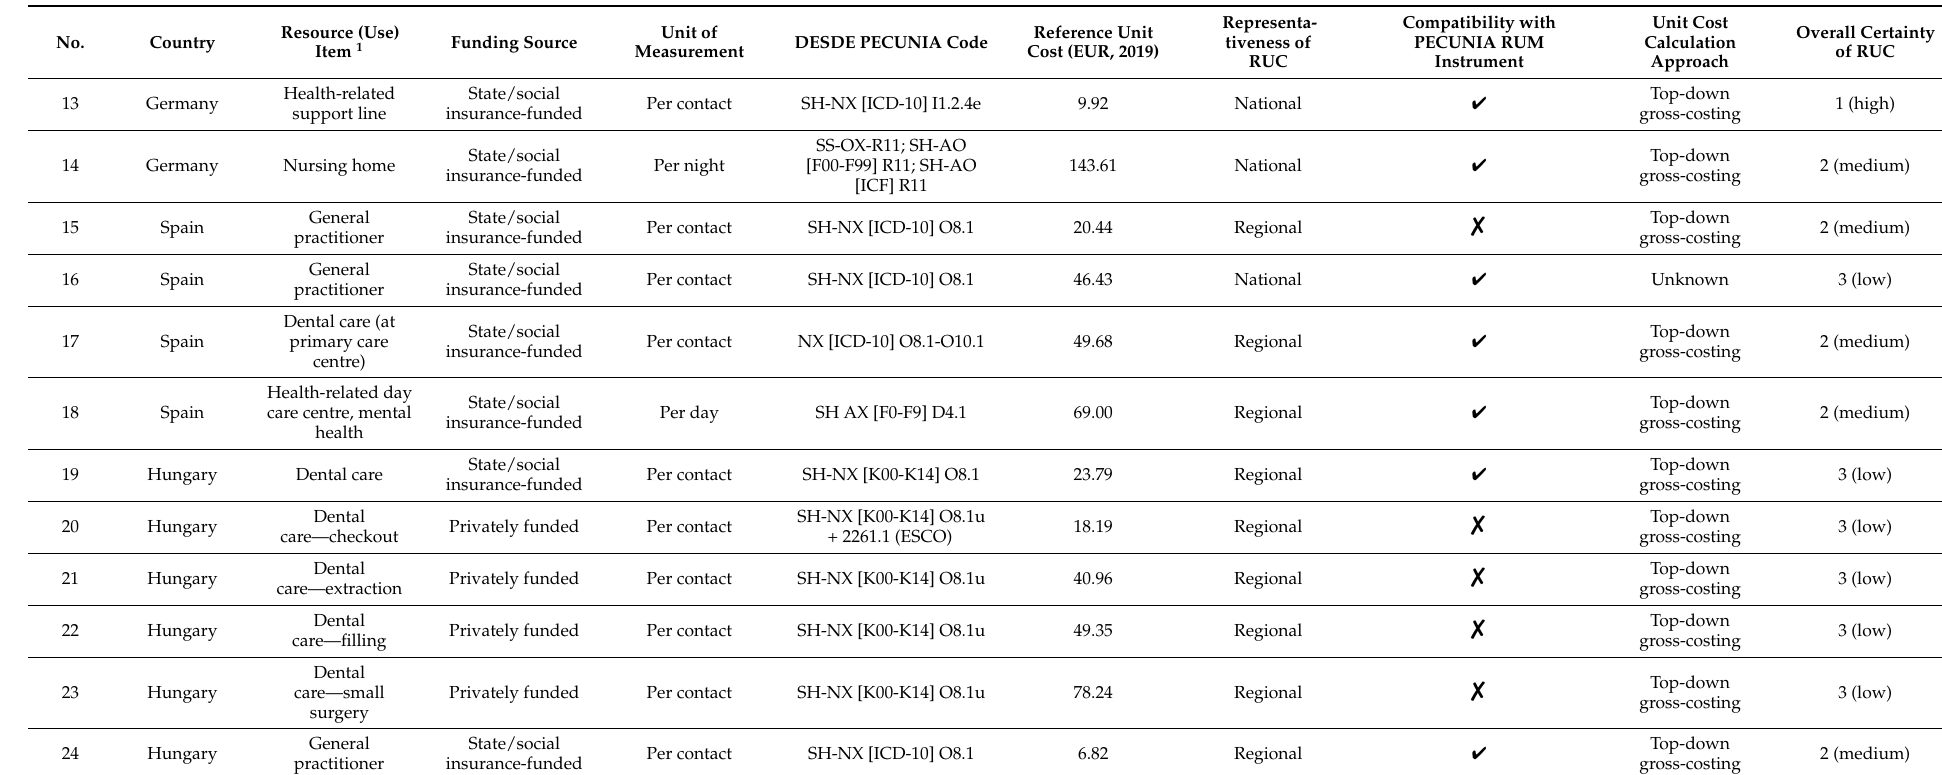
Table 2. Summary of the 36 PECUNIA Reference Unit Cost (RUC) estimates for health and social care services (in EURO, for year 2019). No. Country